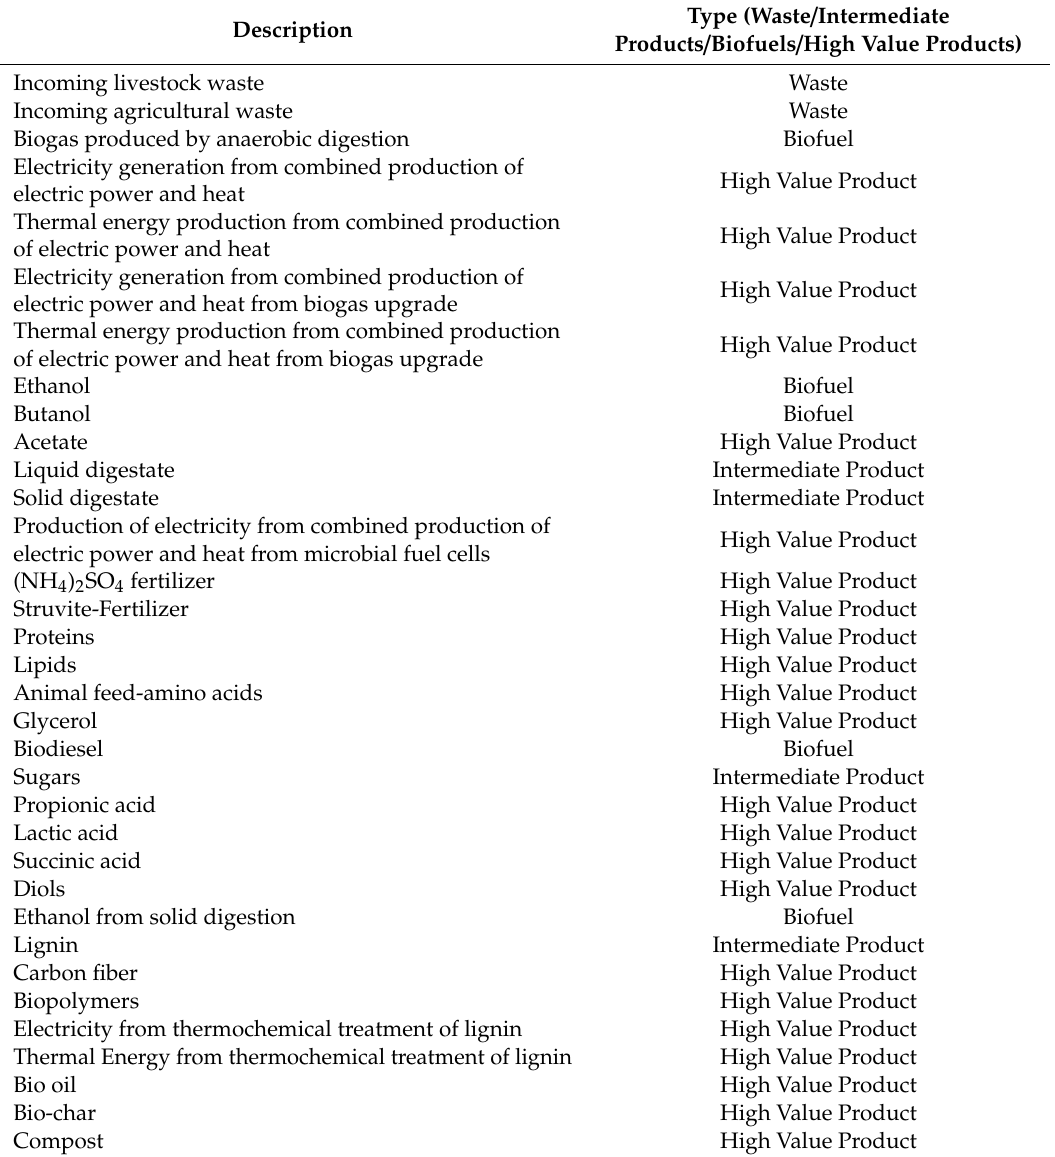
Table 4. Waste, intermediate products, biofuels, and high value products in a biorefinery